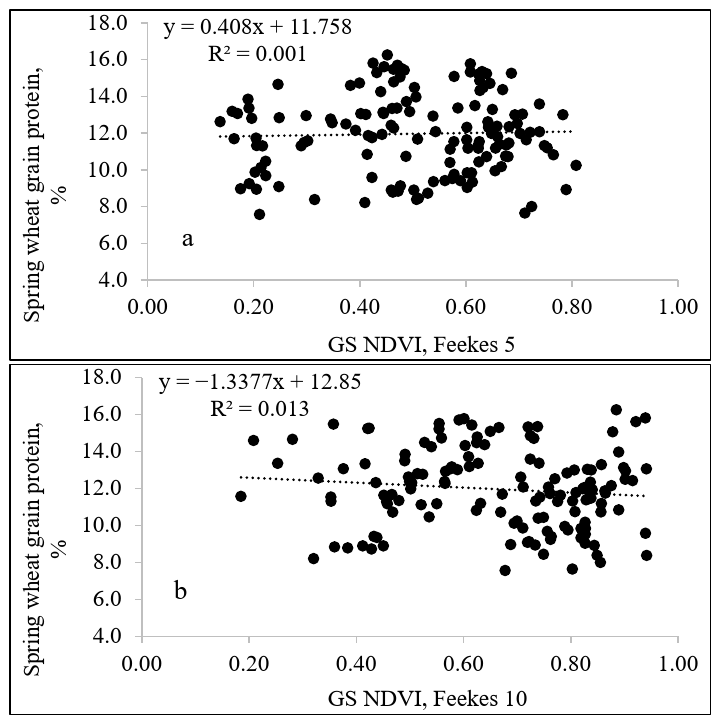
Figure 7. Relationship between Normalized Difference Vegetative Index (NDVI) at Feekes 5 ( a ) and Feekes 10 ( b ) growth stages collected using the GreenSeeker (GS) sensor and spring wheat grain protein content (%), for fourteen site-years in Idaho, 2015–2017.